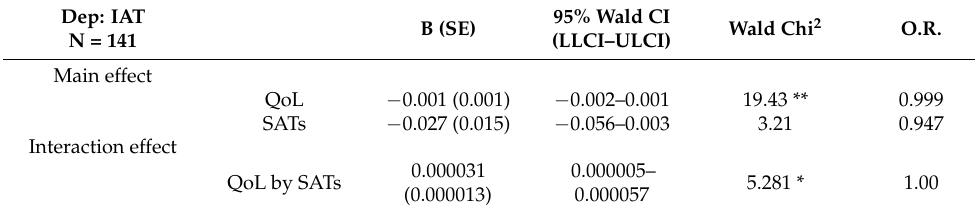
Table 4. Parameter estimates of the relationship between QoL and IAT moderated by